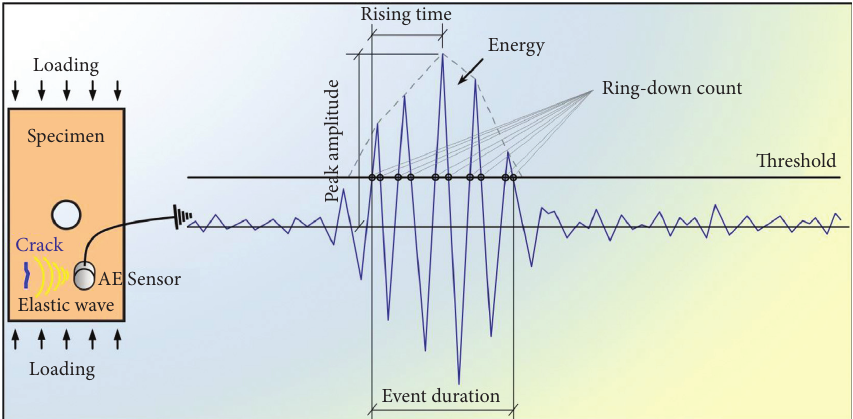
Figure 3: Illustration of typical AE waveform characteristics.